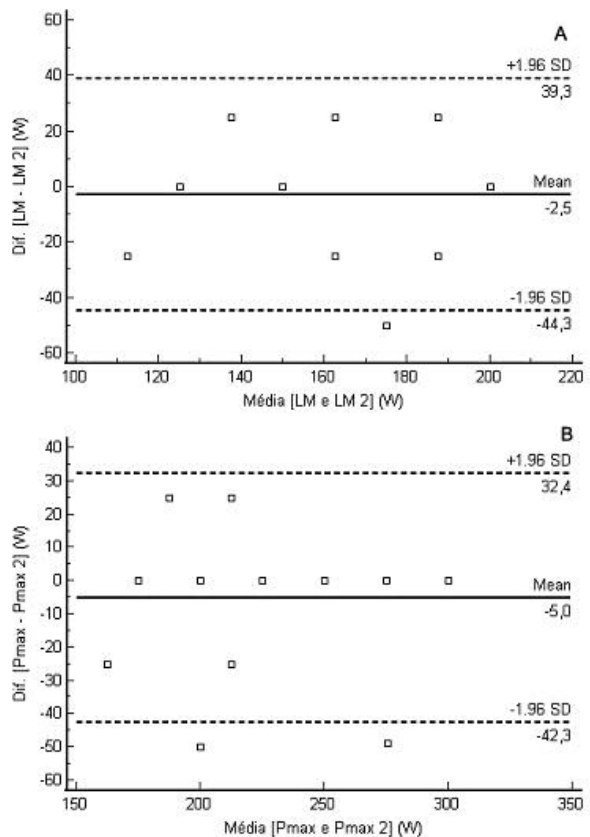
Figura 2A e 2B. Plotagem de Bland e Altman para comparações entre as intensidades de lactato mínimo (LM) (A) e potência máxima (Pmax) (B) obtidas nos testes 1 e 2.